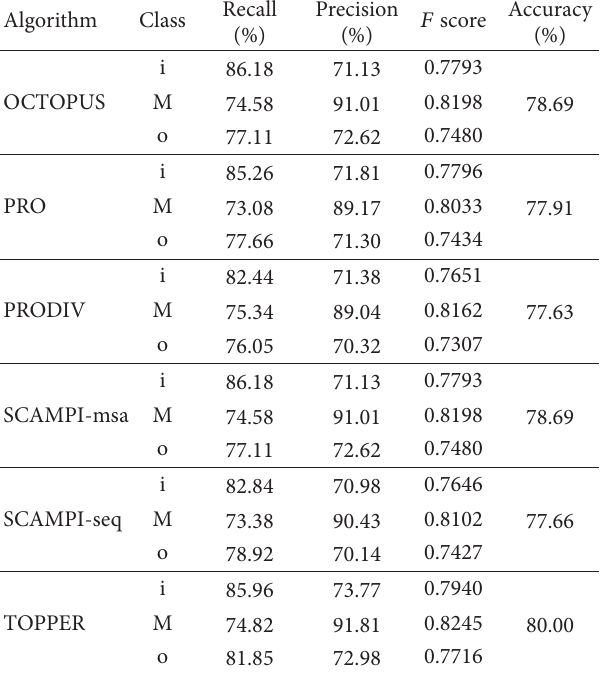
T 2: Prediction performance of various algorithms in residue level. Algorithm